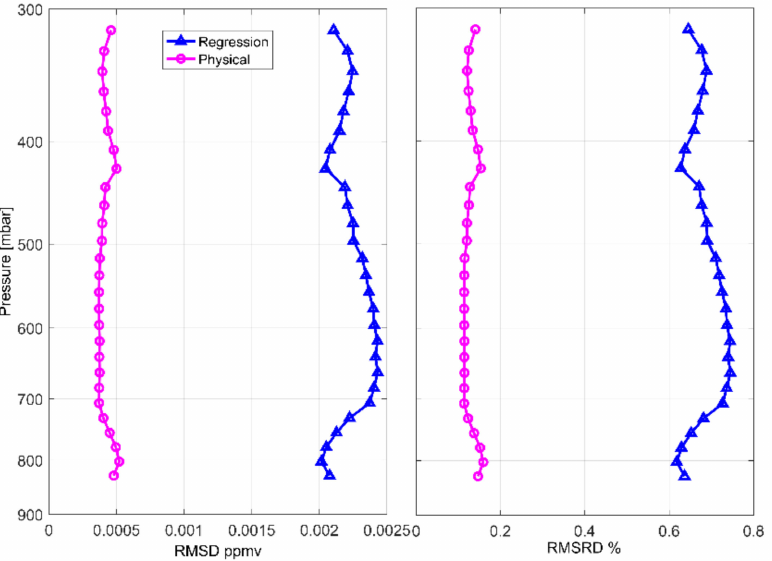
Figure 11. The root-mean-square deviation (RMSD) and root-mean-square RD (RMSRD) of the retrievals using all HIPPO data selected in Table